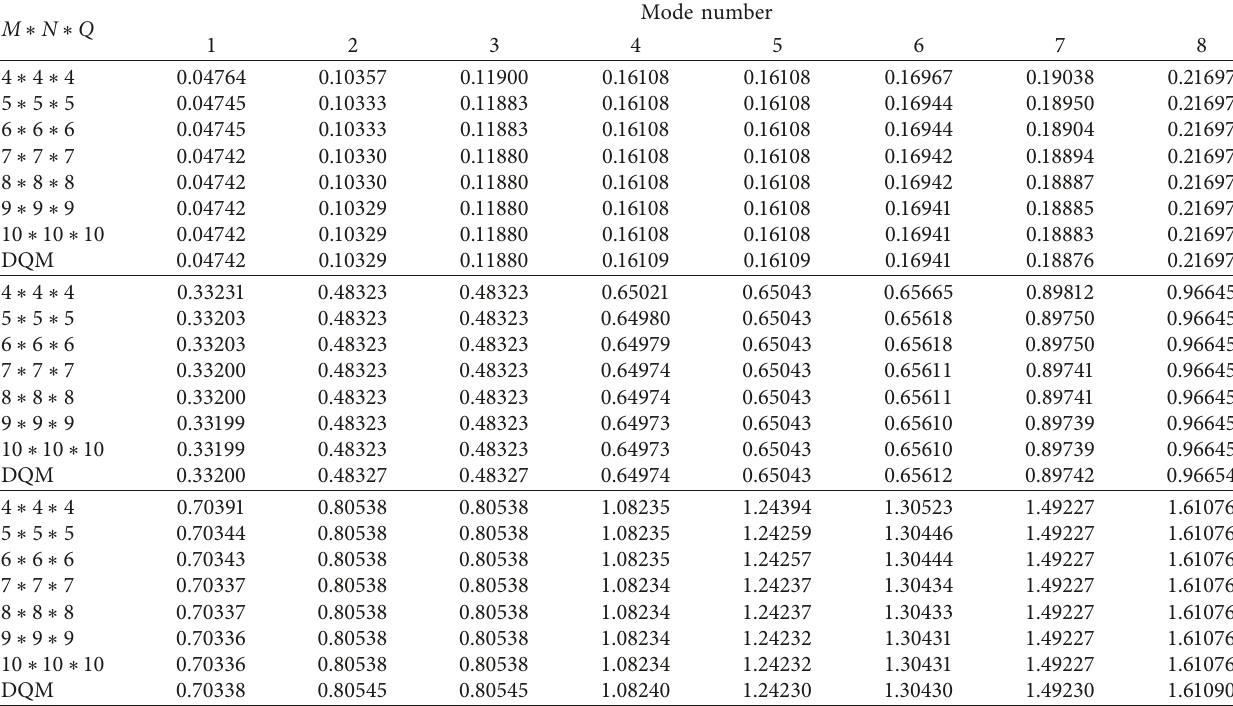
Table 1: Convergence of frequency parameters Ω of an orthotropic plate with different truncated numbers.